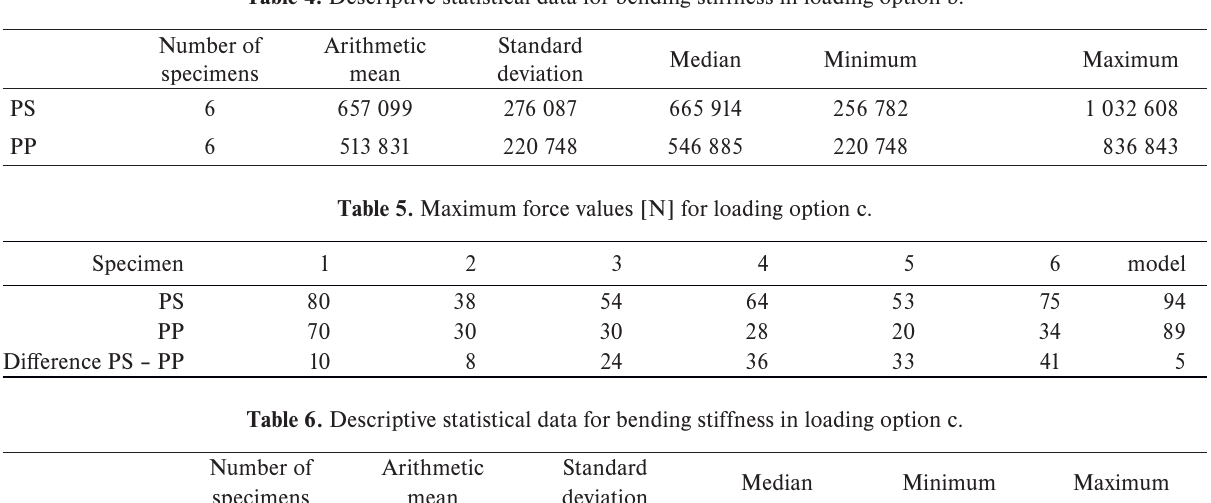
Table 4. Descriptive statistical data for bending stiffness in loading option b.